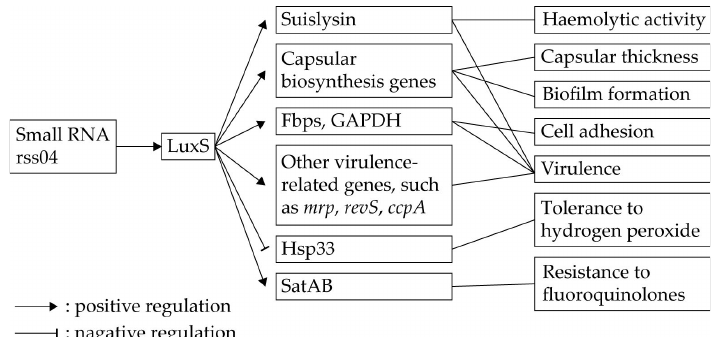
Figure 1. Gene regulation and functions of S-ribosylhomocysteinase (LuxS) in S. suis . LuxS is positively regulated by small RNA rss04. LuxS regulates the expression of multiple genes associated with various phenotypes of S. suis